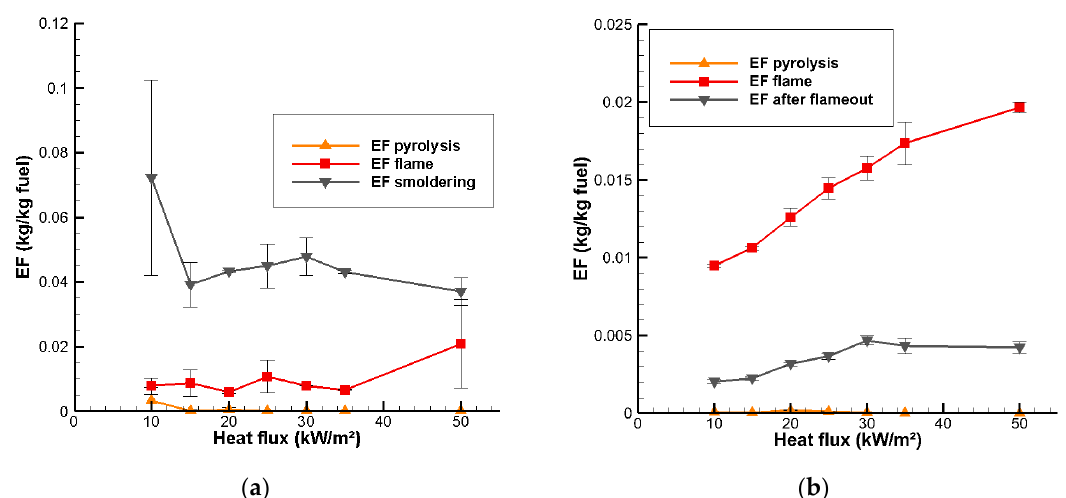
Figure 13. EF for CO for an imposed heat flux ranging from 10 to 50 kW/m 2 for ( a ) wood and ( b ) thermoplastic samples.